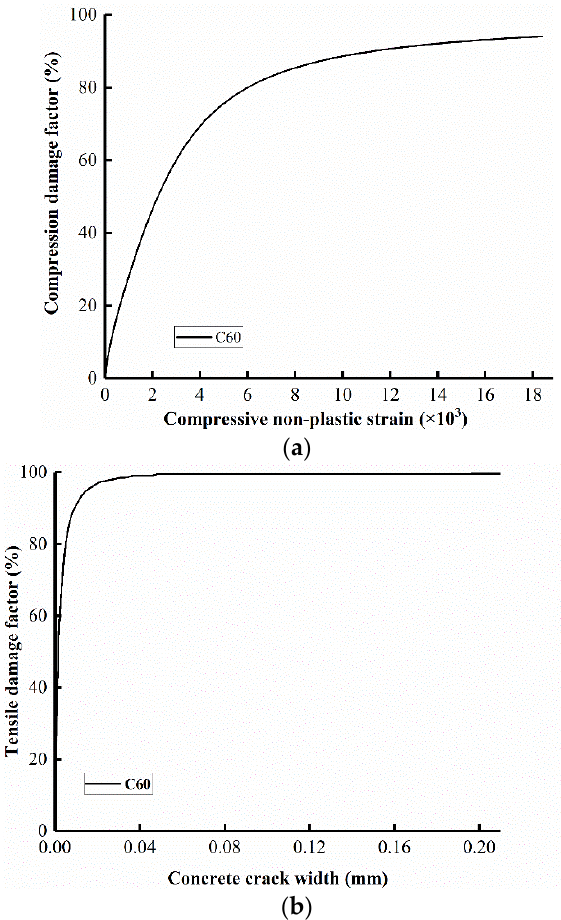
Figure 7. Damage factor definition curve: ( a ) compression damage factor; ( b ) tensile damage factor.